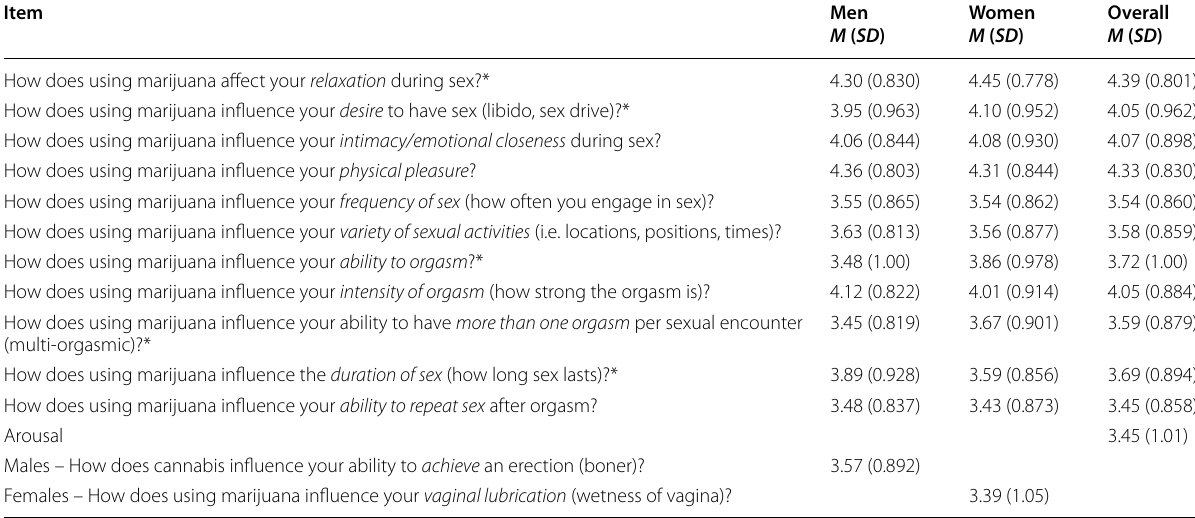
Means range from 1 (significantly decreases) to 5 (significantly increases) with 3 being“does not change” * p <